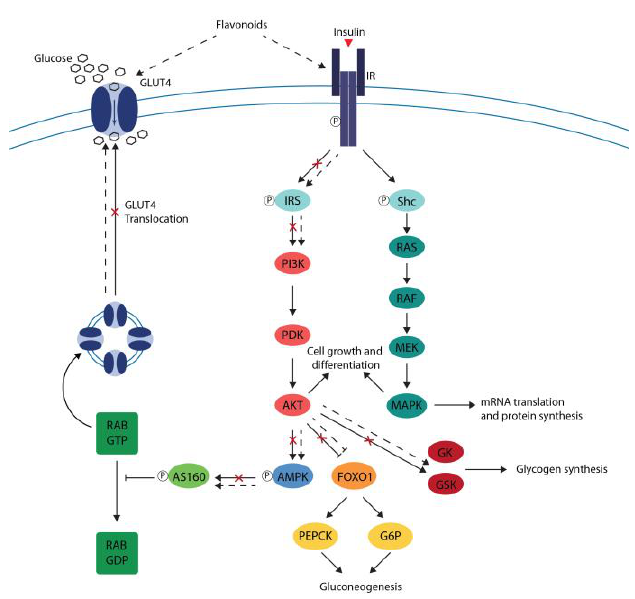
Figure 3. E ff ects of flavonoids on impaired insulin signaling. Flavonoids induce IR and IRS phosphorylation and activate PI3K / Akt pathway and AMPK, promoting GLUT4 translocation in Figure 3. Effects of flavonoids on impaired insulin signaling. Flavonoids induce IR and IRS skeletal muscle and adipose tissues. In the liver, the PI3K / Akt pathway activated by flavonoids phosphorylation and activate PI3K/Akt pathway and AMPK, promoting GLUT4 translocation in decreases PEPCK and G6P expression, suppressing gluconeogenesis and increasing GK and GSK expression, promoting glycogen